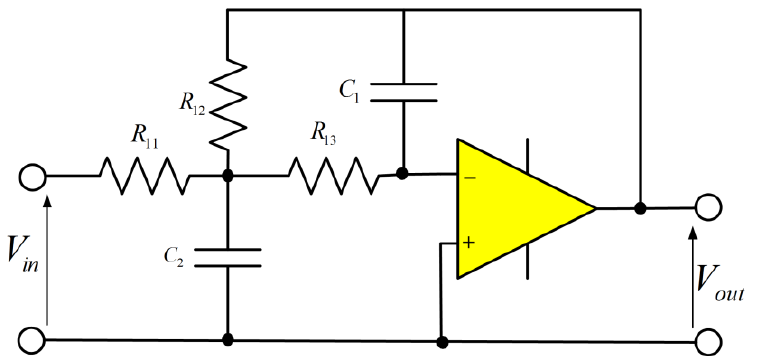
Figure 11. Active low-pass filter diagram.